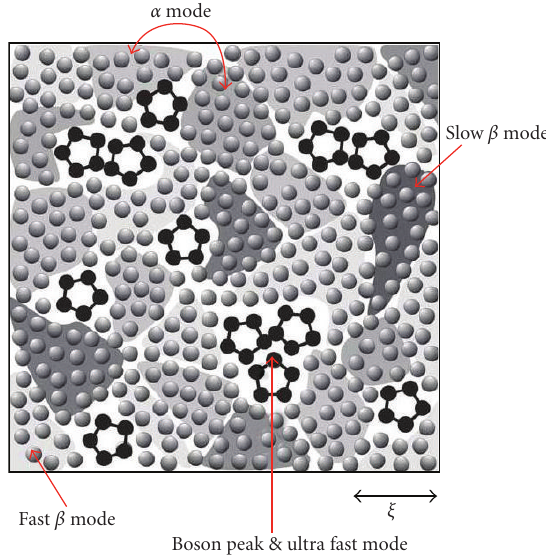
Figure 8: Schematic figure of a supercooled liquid state below melting temperature. LFS: black pentagons, NLS: grey spheres. Shaded region represents metastable islands with various degrees of crystal-like order, whose characteristic coherence length is ξ . The darker the colour is, the higher the crystal-like order and the higher the local density are [79]. Courtesy Hajime